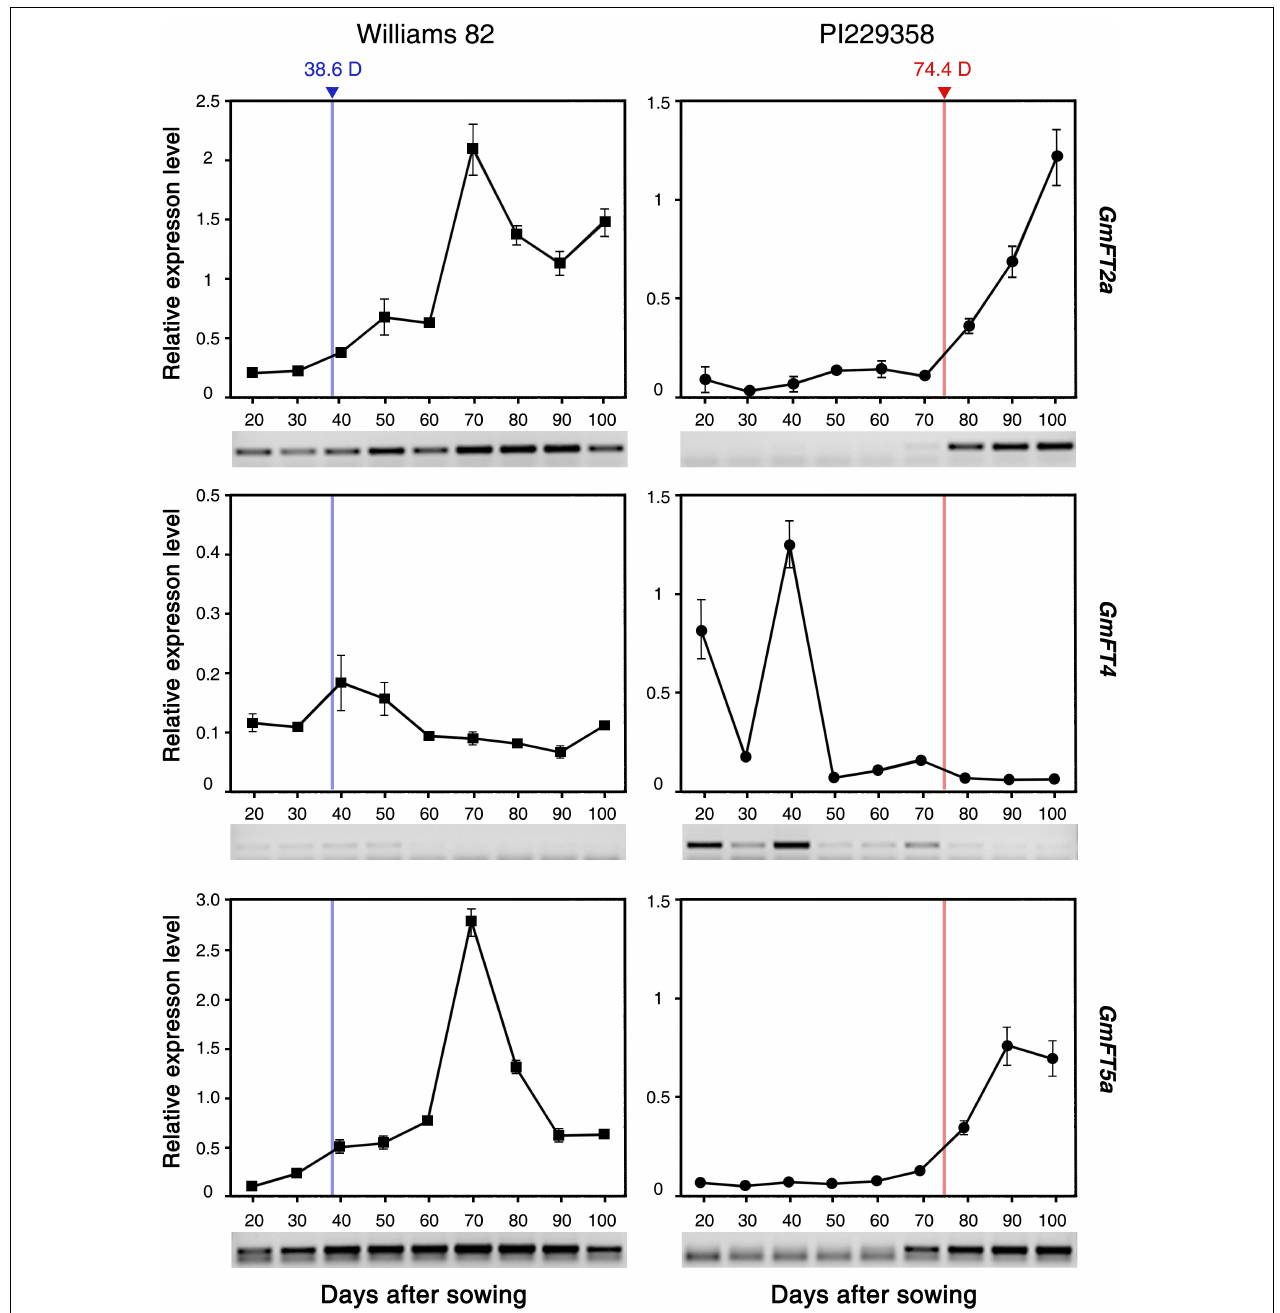
FIGURE 8 | Expression of GmFT2a , GmFT5a , and GmFT4 mRNAs in leaves of early (Williams 82)- and late (PI229358)-flowering soybean accessions across different developmental stages. Fully expended trifoliate leaves from the top of the main stem were harvested from three independent plants grown in natural field conditions from 20 to 100 days after sowing. Relative mRNA levels of GmFT genes were analyzed by quantitative real-time PCR with three independent biological replicates and normalized to GmPBB2 mRNA. Days to flowering of Williams 82 (38.6D) and PI229358 (74.4D) are indicated by blue and red line, respectively. The result of independent RT-PCR experiments is also shown below each graph. Data is shown as mean ± standard